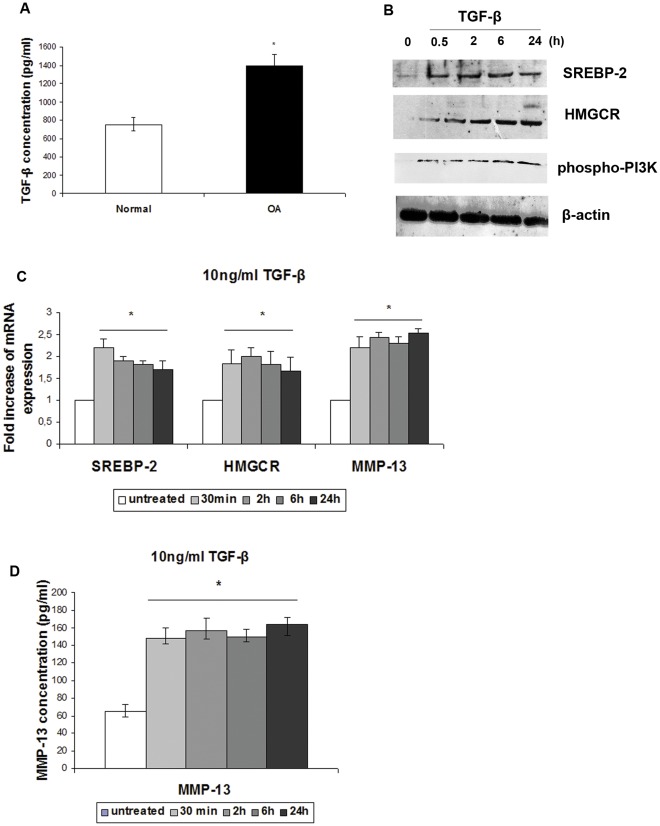
TGF-β expression in normal and osteoarthritic chondrocytes and effect of TGF-β treatment on SREBP-2, HMGCR, phospho-PI3K and MMP-13 expression.(A) TGF-β expression levels in normal and osteoarthritic chondrocytes detected by ELISA. *p<0.05 (B) Western blot showing SREBP-2, HMGCR and phospho-PI3K protein expression levels in normal and osteoarthritic chondrocytes treated with 10 ng/ml TGF-β for 0.5, 2, 6, and 24 h. β-actin was used as loading control. The same membrane was reprobed without stripping. (C) SREBP-2, HMGCR and MMP-13 mRNA in cultured normal chondrocytes following treatment with 10 ng/ml TGF-β for 0.5, 2, 6 and 24 h. All experiments were performed in duplicate and data are expressed as mean. *p<0.05 (D) MMP-13 protein expression levels in normal chondrocytes following treatment with 10 ng/ml TGF-β for 0.5, 2, 6 and 24 h detected by ELISA. *p<0.05.